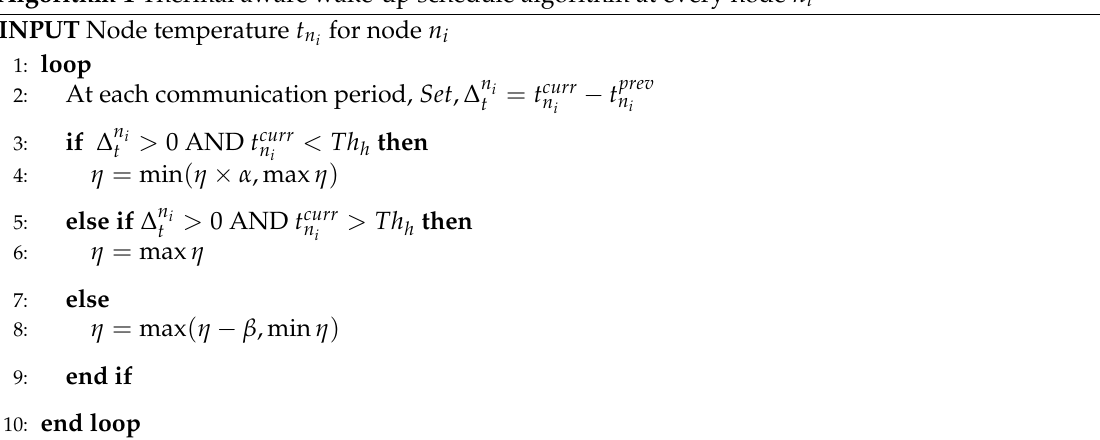
Algorithm 1 Thermal aware wake-up schedule algorithm at every node n